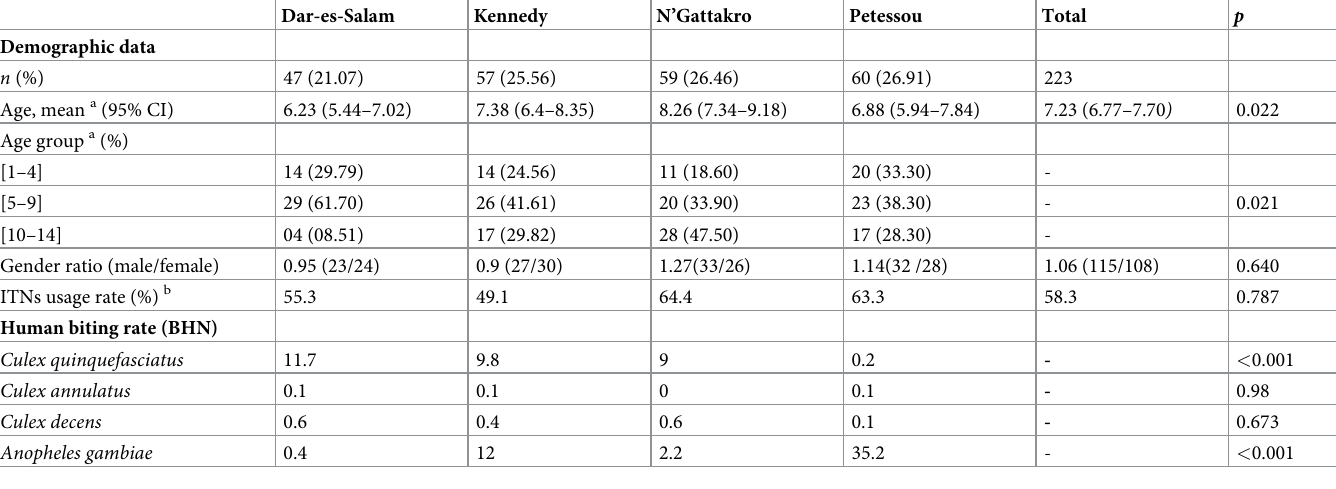
Table 1. Study population characteristics and entomological data according to the study